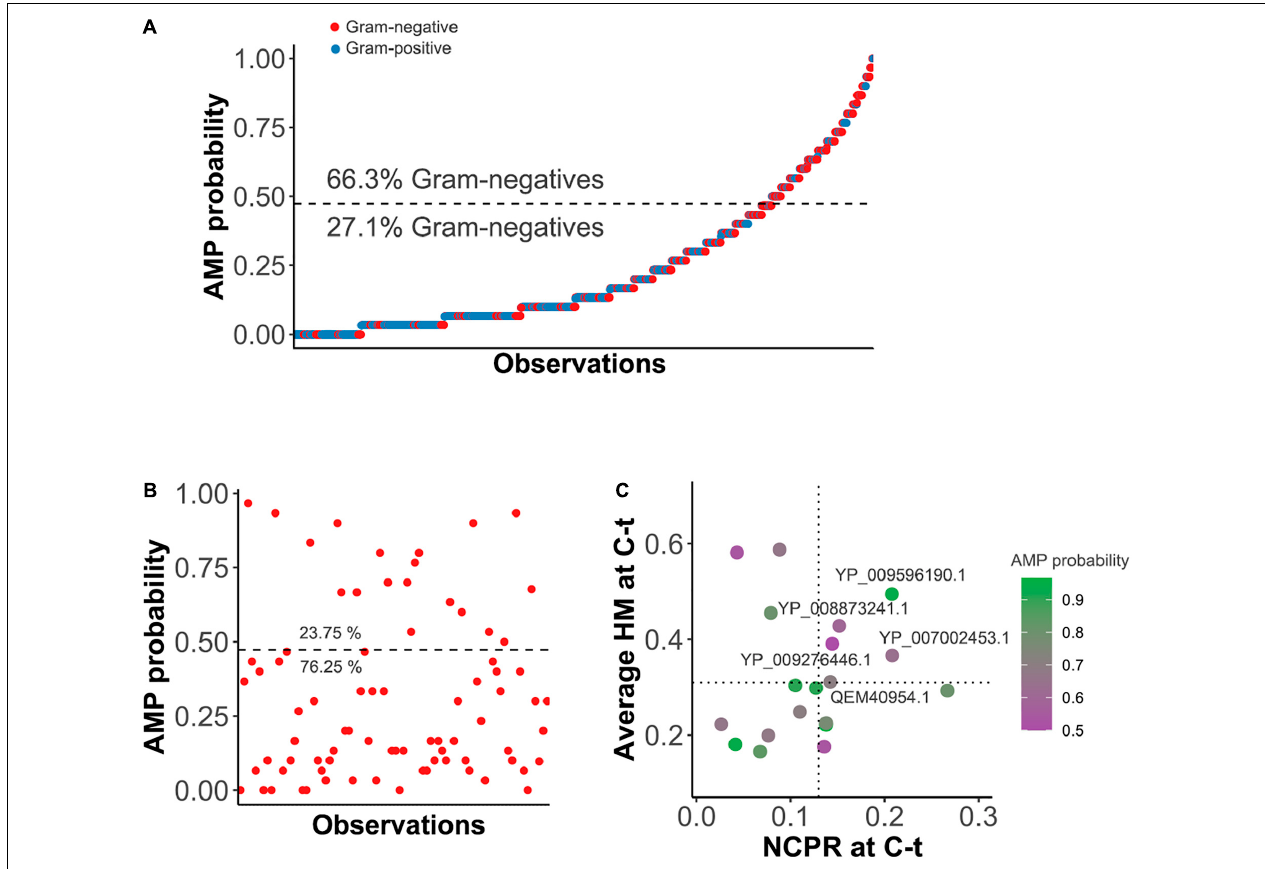
FIGURE 2 | Prediction of AMPs within the C-terminal end (C-t) of lysins. (A) C-terminal AMP prediction on lysins from G+ or G- infecting phages within S LYS . Dashed line represents the AMP probability cut-point for classification derived from the ROC best point. Percentages of the observations corresponding to G- above or below the classification threshold are depicted. (B) AMPs prediction within S PSE . The horizontal dashed line is the classification cut-point value. (C) Further screening of AMP-positive entries of S PSE . Average hydrophobic moment (HM) and net charge per residue (NCPR) for the C-terminal patch of the lysins are shown, as well as